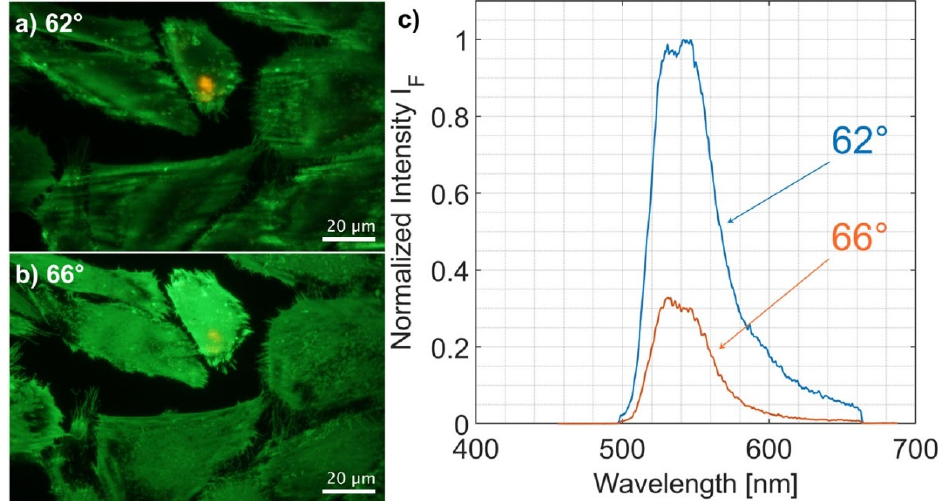
Figure 5. Fluorescence images ( a , b ) and fluorescence spectra ( c ) of CHO ‐ pAcGFP1 ‐ Mem cells 24 h after incubation with doxorubicin for Θ = 62° (whole cell excitation) and Θ = 66° (TIR excitation). Fluorescence images excited at Θ = 62° show some additional red fluorescence due to doxorubicin, which almost disappears at Θ = 66°. Fluorescence spectra excited at Θ = 62° exhibit two emission maxima around 530 nm (GFP) and 543 nm with a long ‐ wave tail, possibly related to doxorubicin or its degradation product. The long ‐ wave part of the spectrum is less pronounced in the TIRFM ex ‐ periments.